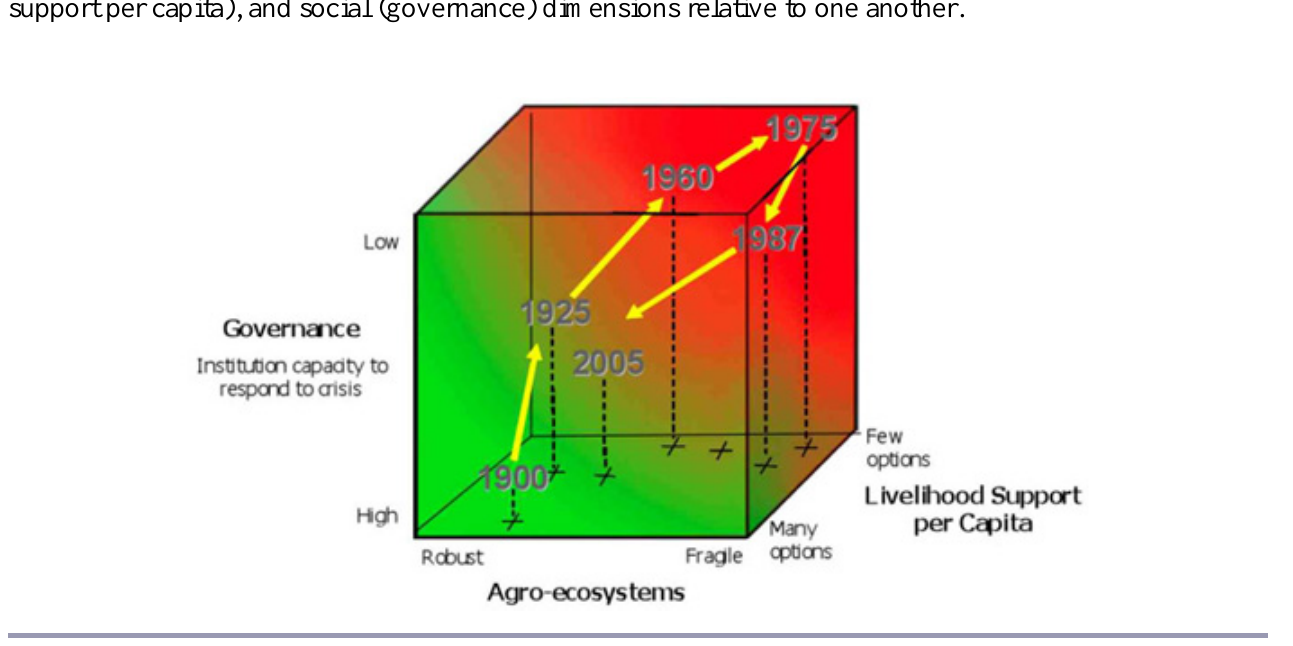
Fig. 11 . Changes in resilience of Nigerien farmers to drought in the Maradi and Zinder Regions of Niger in the twentieth century as reflected in changes in biophysical (agro-ecosystems), economic (livelihood support per capita), and social (governance) dimensions relative to one